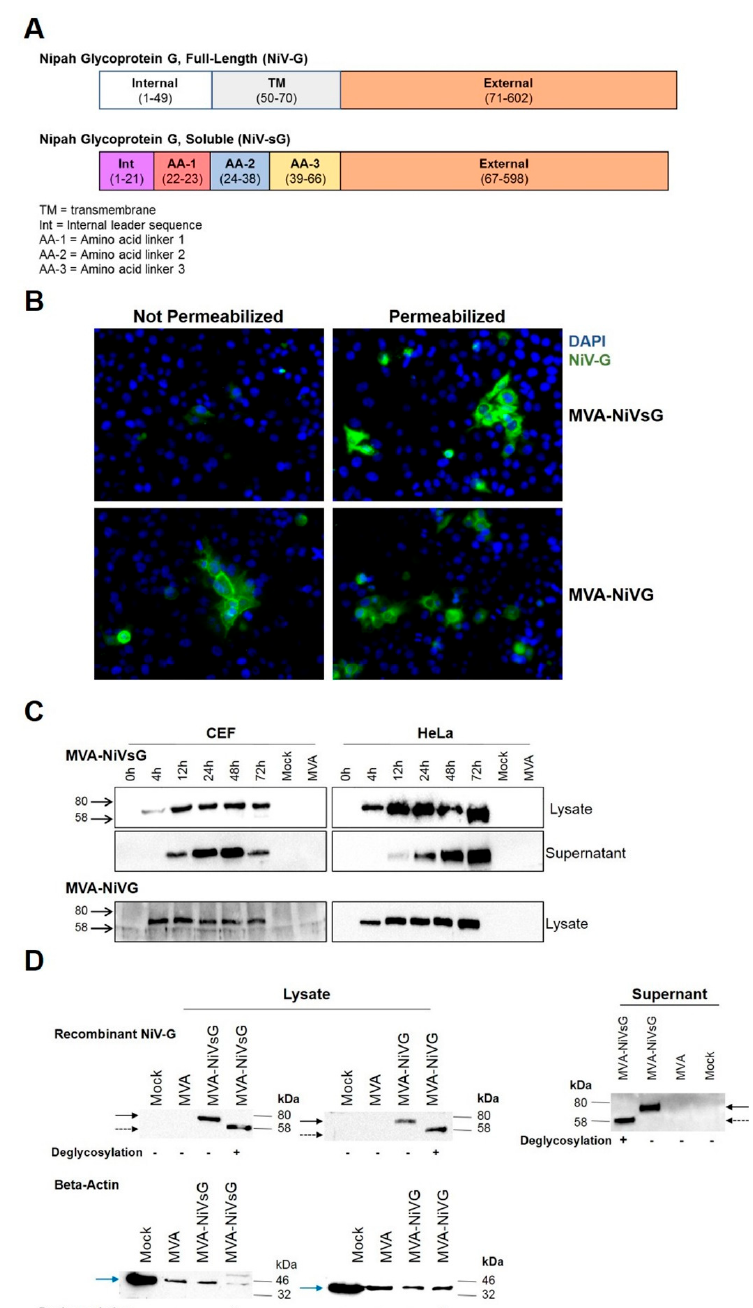
Figure 1. Analysis of recombinant Nipah virus full-length glycoprotein G (NiV-G) protein produced by cells infected with MVA–NiVsG and MVA–NiV-G. ( A ) Schematic diagram of recombinant NiV full-length glycoprotein G (NiV-G) and NiV soluble glycoprotein G (NiVsG). Colored rectangles represent individual protein domains, and bracketed text displays the start and end of amino acid sequences of each domain. ( B ) Immunofluorescence staining of cells infected with MVA–NiVsG and MVA–NiV-G. HeLa cells were infected at MOI 0.05 with the above viruses for 16 h. MVA and mock